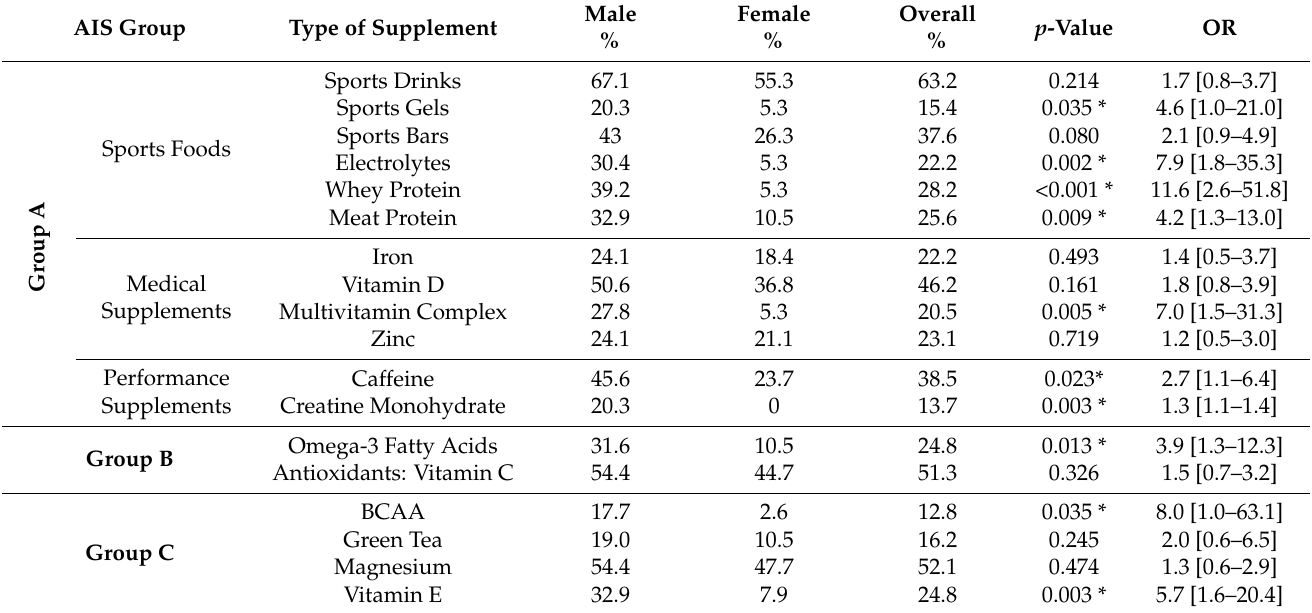
Table 2. DS most consumed by sex according to AIS classification [12].